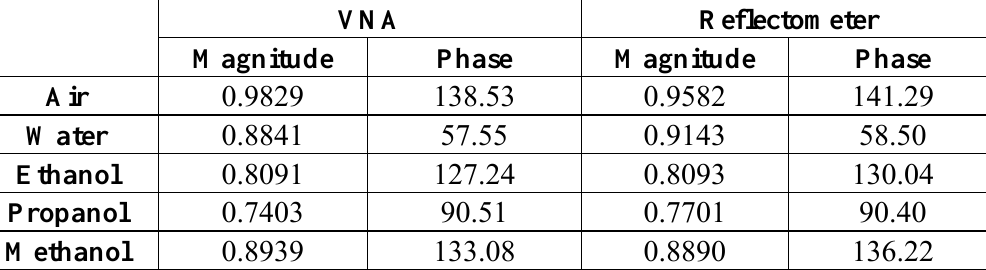
of several known sample using open ended Table 3. S 11